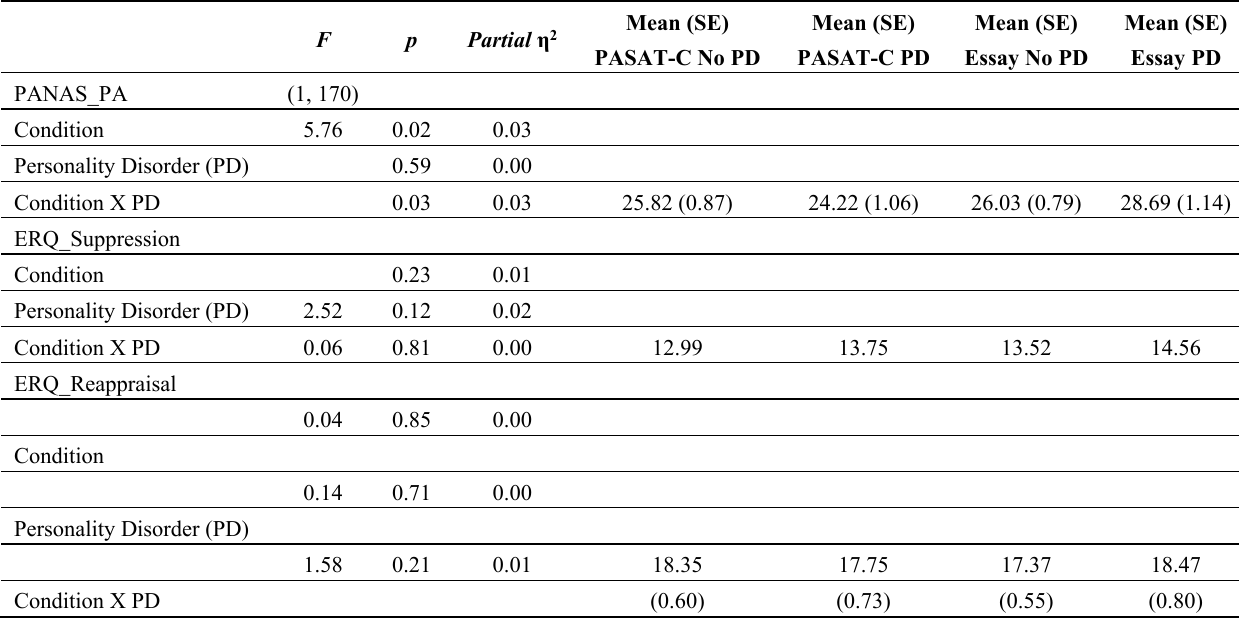
Table 4. ANCOVAs examining the interaction between mood induction, personality disorder, and positive affect, suppression, or reappraisal with pre mood induction positive affect, suppression, and reappraisal scores as